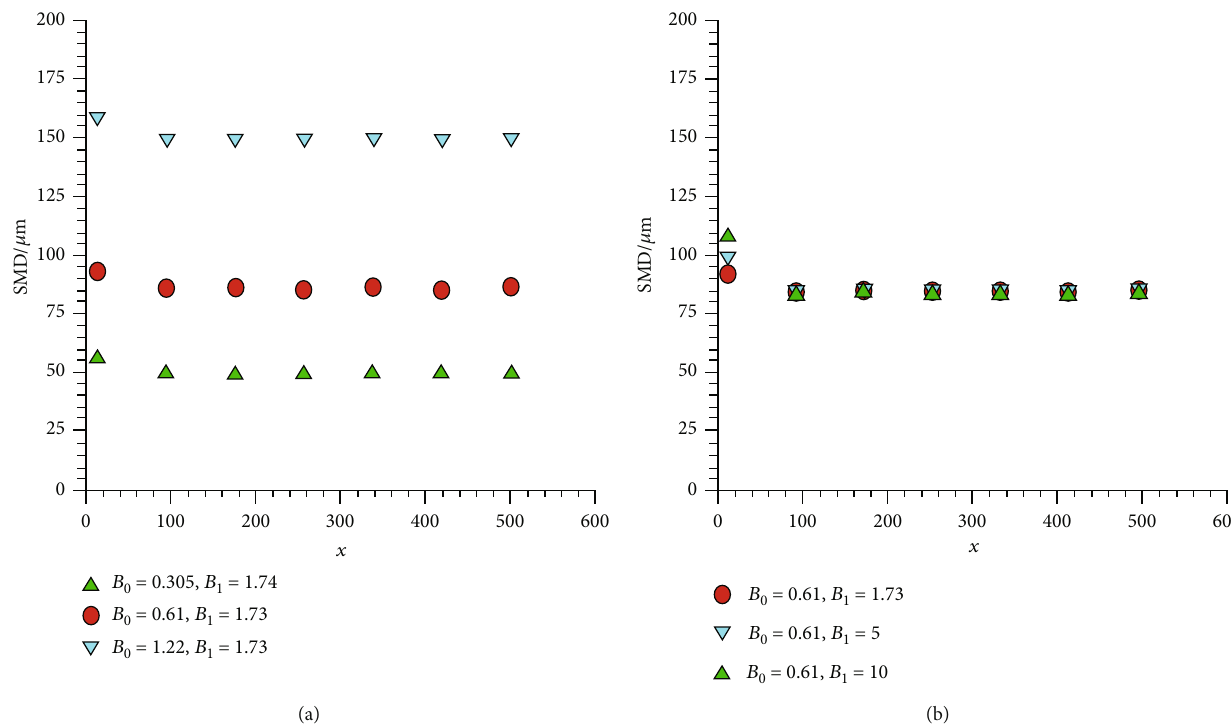
Figure 2: SMD distribution in the free-stream direction with varied KH breakup model constants: (a) B